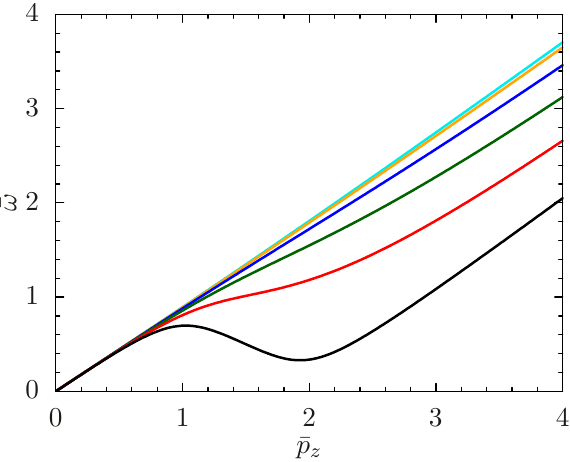
Figure 3 . Dispersion relation of the lightest excitation branch in the BEC phase at p ? = 0 and x = 2 for (cid:22) H = 0 (cyan), 0 : 2 (orange), 0 : 4 (blue), 0 : 6 (green), 0 : 8 (red), and 1